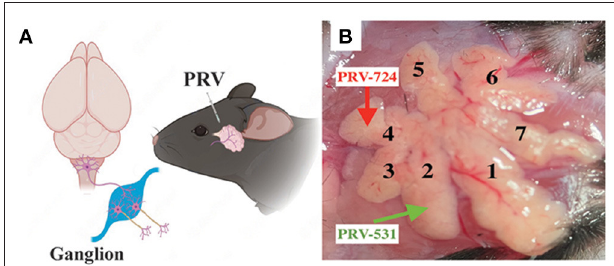
FIGURE 1 | Experimental procedures for the cell-type-specific retrograde trans-multi-synaptic tracing of whole brain. (A) Simplified drawing of ELG’s geographic location on mice, and the general principle of PRV tracing from peripheral ELGs to the central nervous system. (B) Experimental design showing the injection site for C57BL6/J (example injection sites combined lobe No. 2 and lobe No. 4, with PRV531-GFP and PRV724-dsRed injected